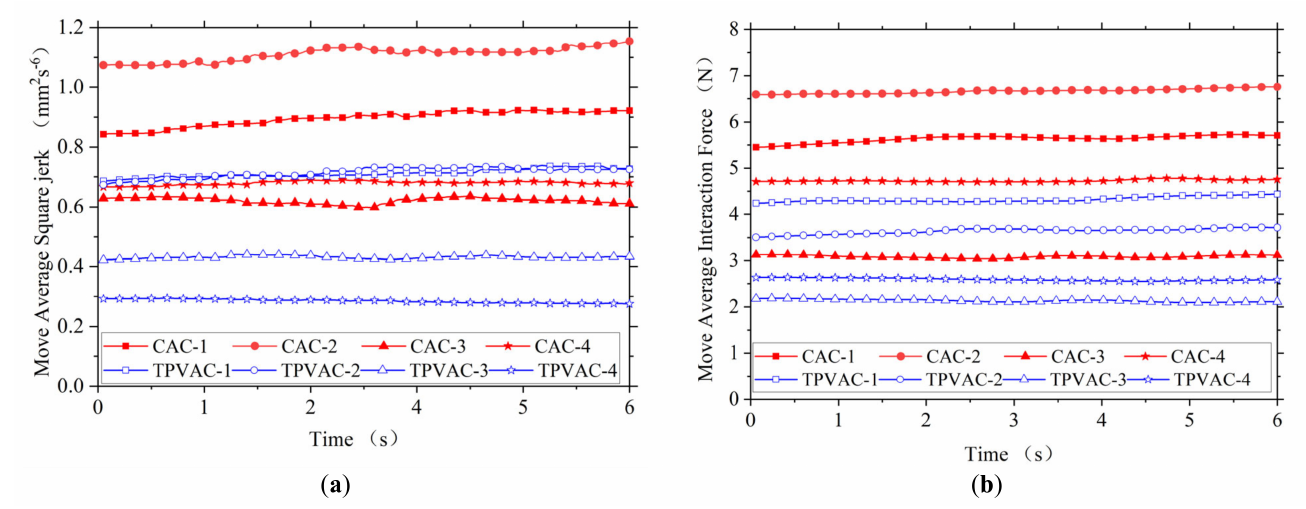
Figure 8. ( a ) The MAS-jerk curves. ( b ) The MA-force